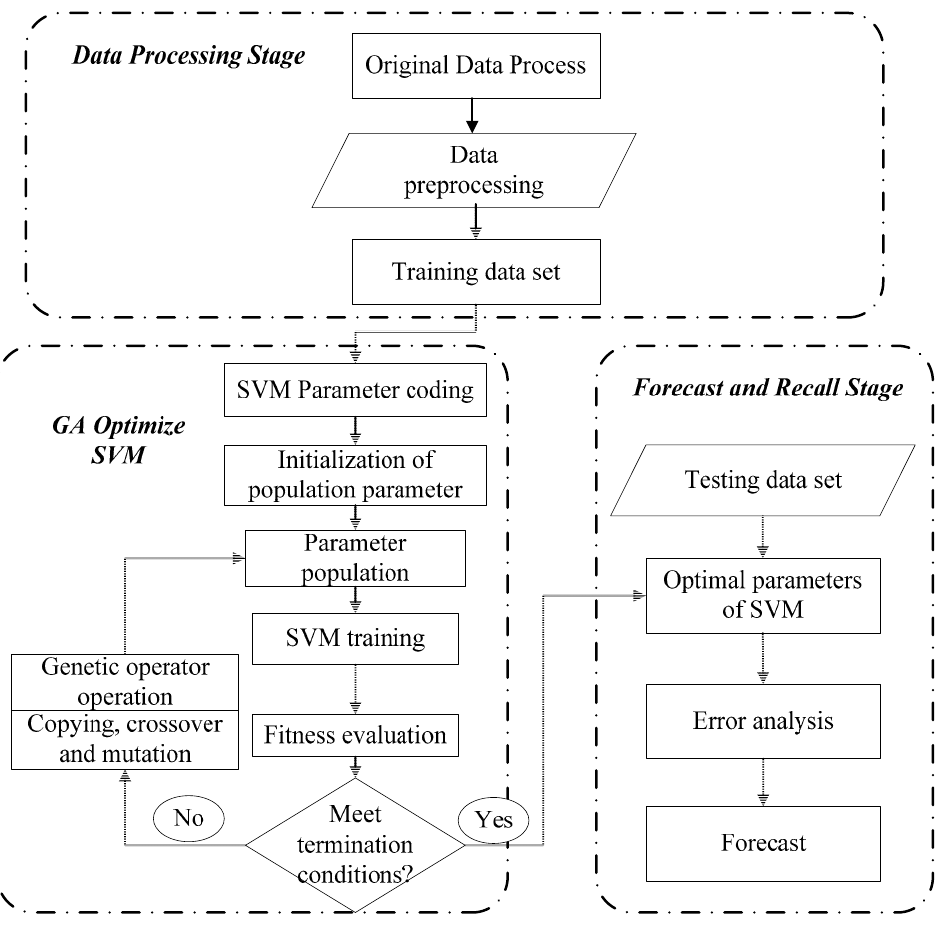
Figure 3. Genetic algorithm (GA)-support vector machine (SVM) based prediction system.